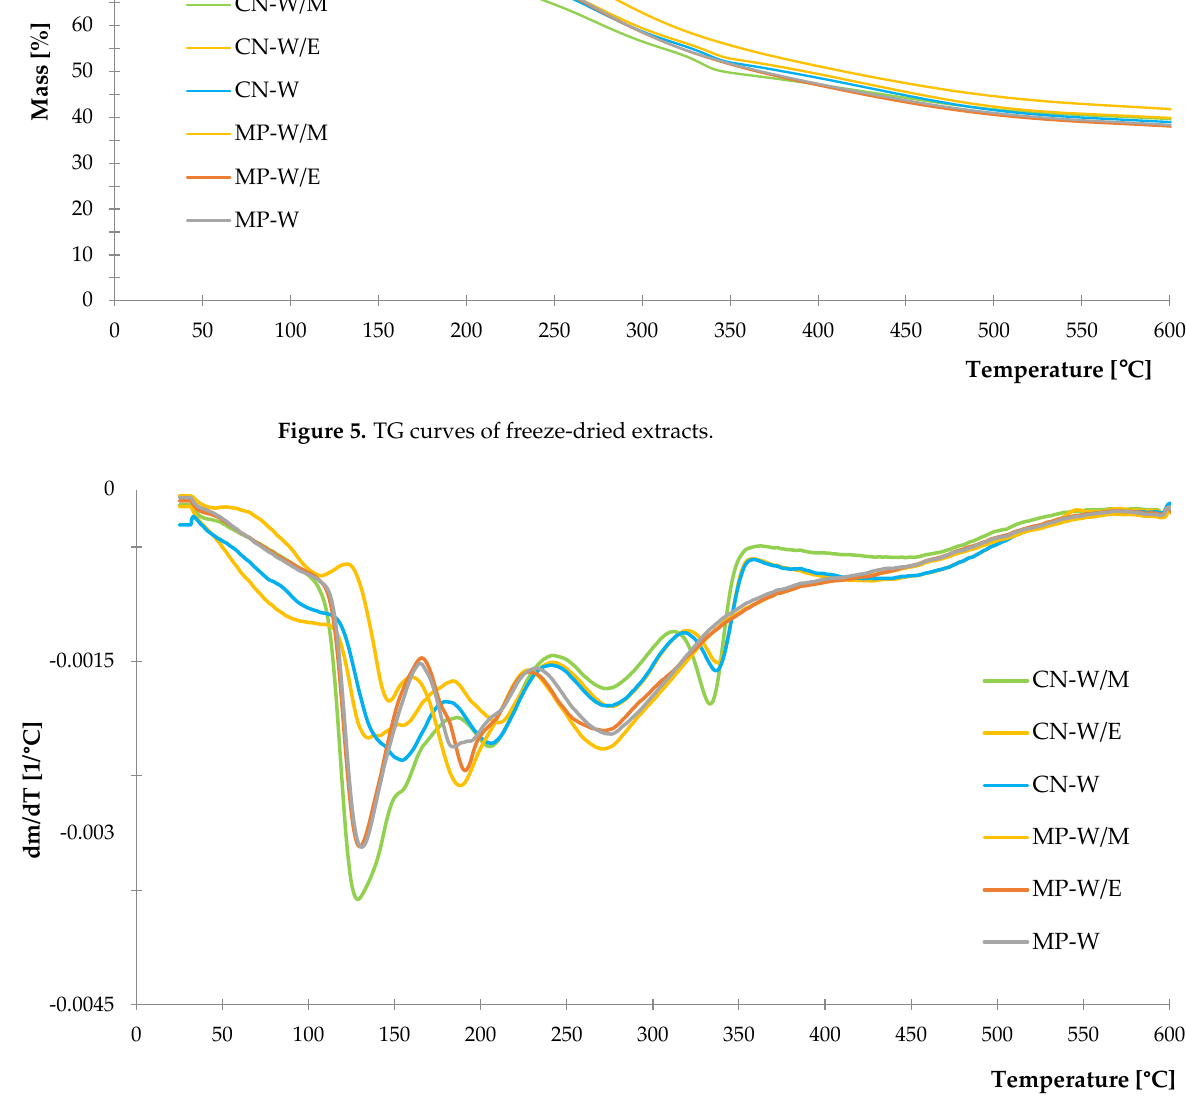
Figure 6. DTG curves of freeze-dried extracts. Table 4. Percantage mass losses (Δm ) of samples in various temperature ranges from 25 to 600 °C and residue after thermal decomposition at 600 °C (R 600 ).